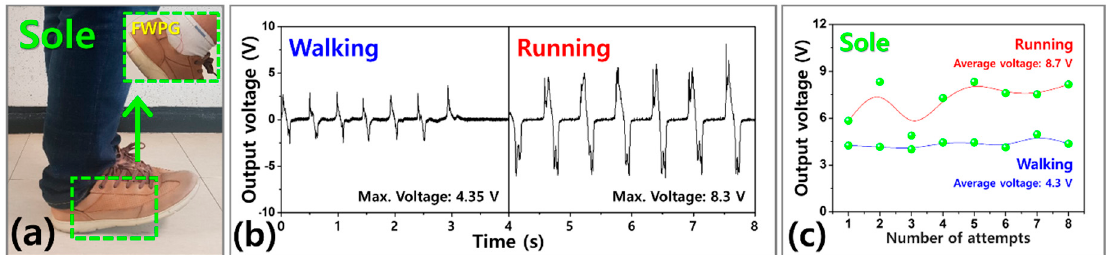
Figure 9. ( a )Photograph of an attached FWPG from the knee. ( b ) Output voltage of the FWPG from the knee when walking and running. ( c ) Average voltage of the FWPG from the knee when a human is walking and running.